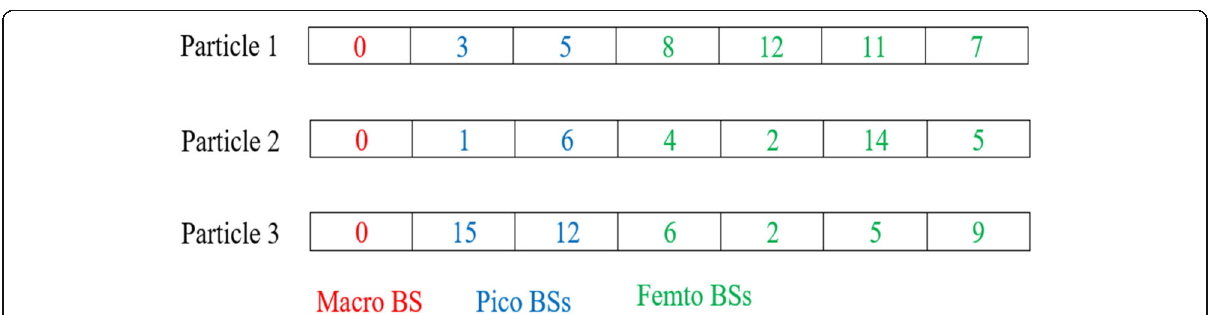
Fig. 3 An example of three particles that generate per-BS biasing values. This figure provides an example of a number of particles that represents the per base station biasing